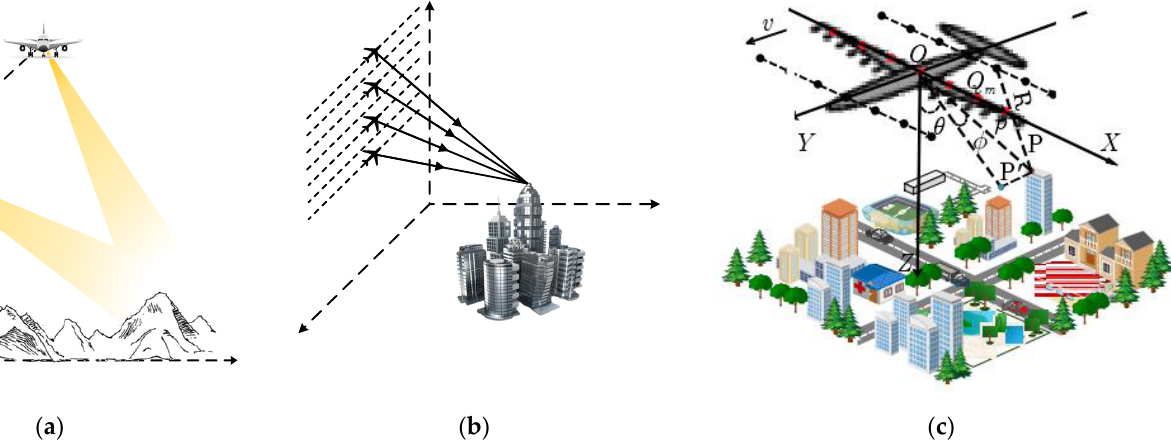
Figure 1. 3-D SAR coordinate extraction techniques based on 2-D synthetic aperture. ( a ) In-SAR. ( b ) Tomo-SAR. ( c )